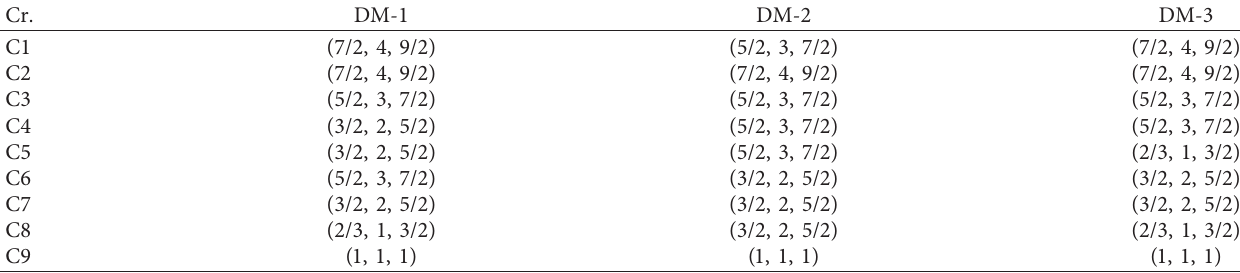
Table 8: Preference of all other criteria with regard to the worst criterion using TFNs (others-to-worst vector). Cr.